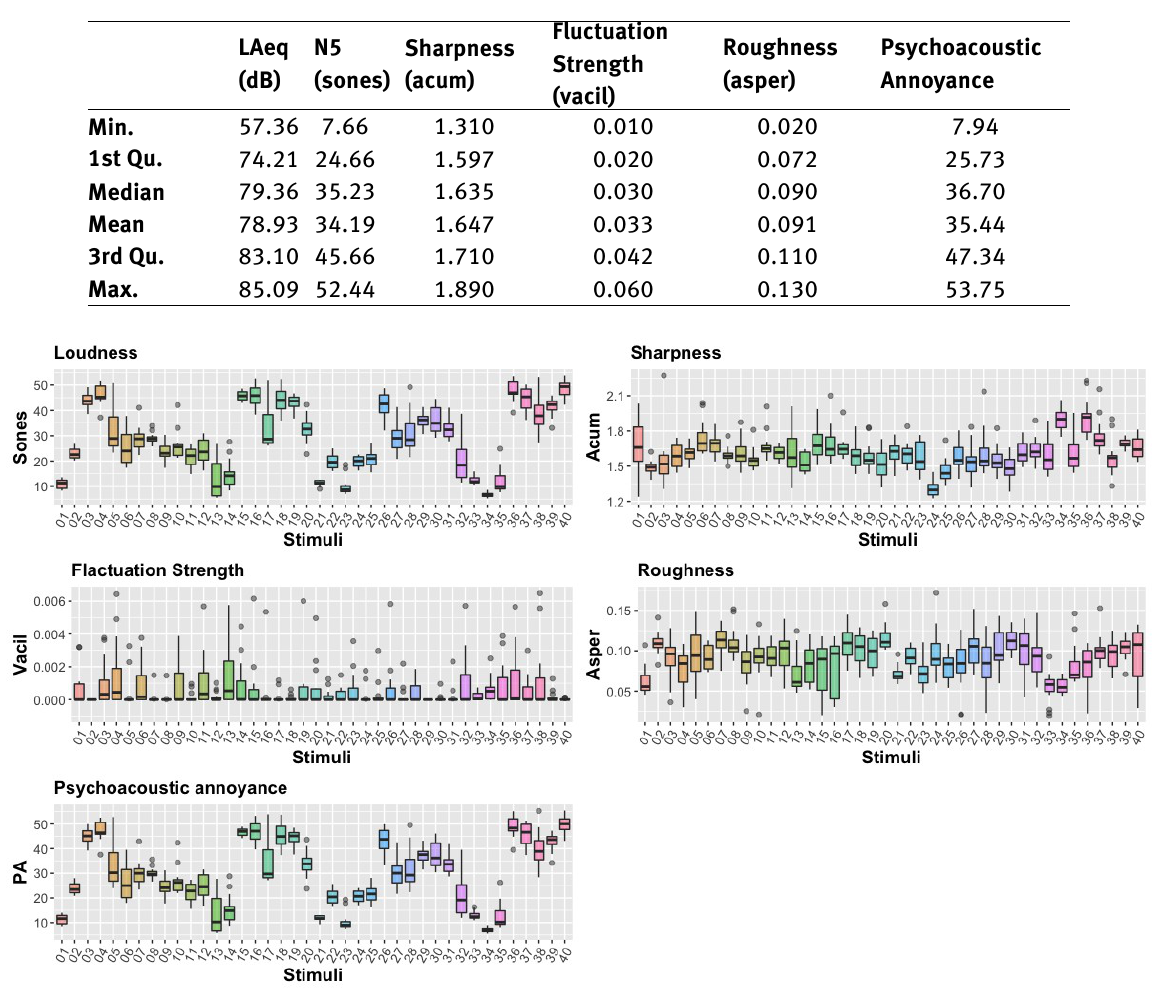
Figure 2: Variation of psychoacoustic indicators across all 40